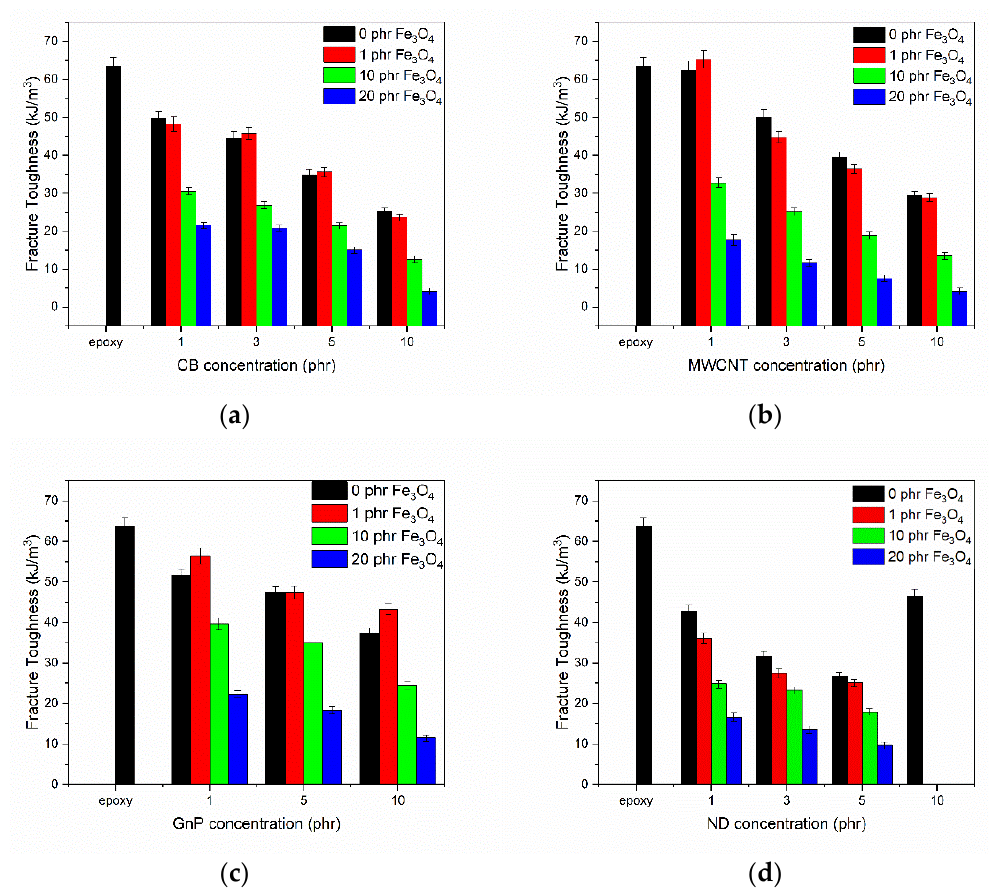
Figure 8. Fracture toughness as a function of ( a ) CB; ( b ) MWCNT; ( c ) GnP; ( d ) ND concentration for all examined